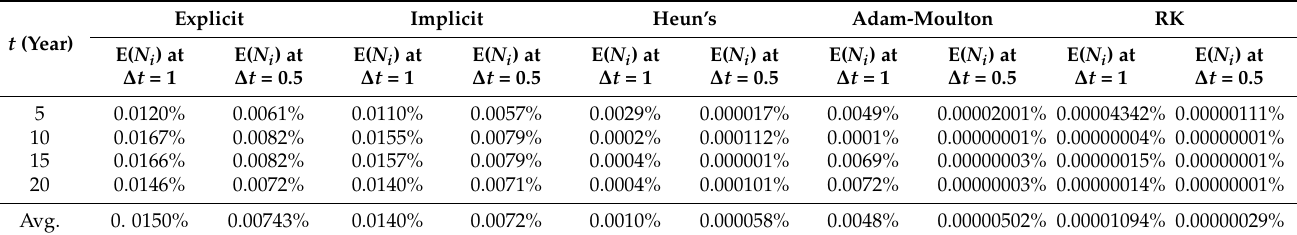
Table 5. The effect of changing ∆ t on the results of N i .